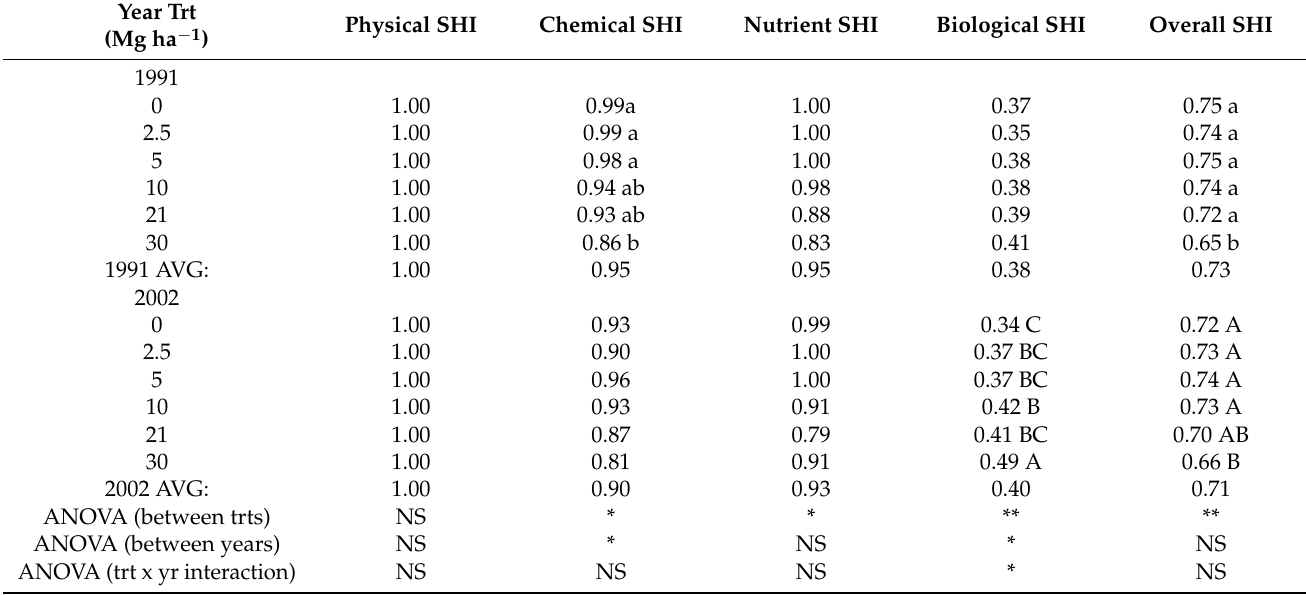
Table 4. Mean soil physical, chemical, nutrient, biological, and overall soil health index (SHI) scores (0.00 to 1.00; greater is “better”) from soil collected from the 0–15 cm depth (collected in 2018), as affected by increasing single (applied in 1991) or repeated (applied in 2002) biosolids applications to a degraded rangeland at the Fort Collins, Colorado, USA Meadow Springs Ranch. When present, different letters between treatments within a given application year represent significant differences at the p < 0.05